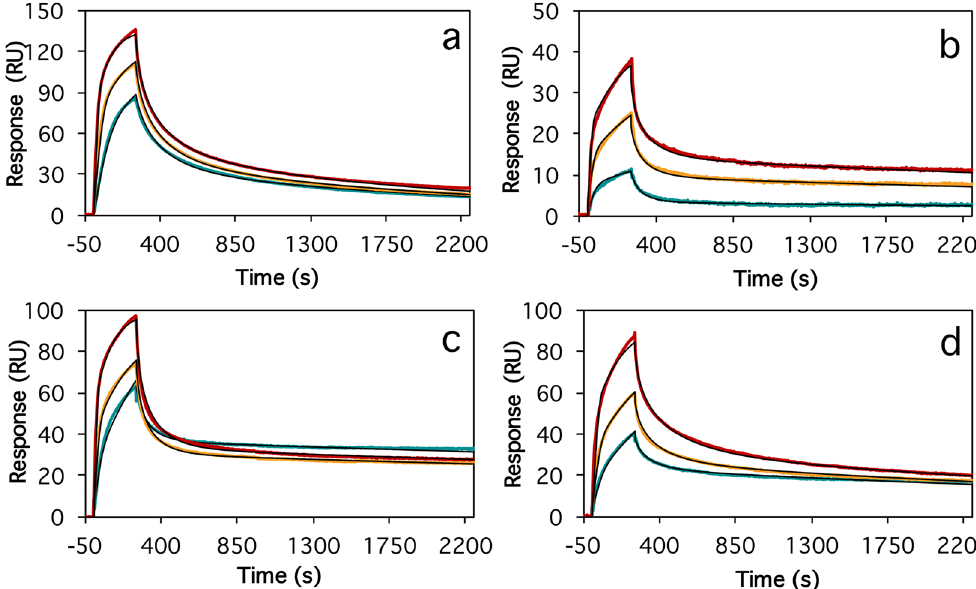
Figure 5. Association and dissociation kinetics for binding of some of the head-to-tail Affibody dimers to immobilized A β 42 cc protofibrils. Data were fit to a heterogeneous ligand binding model with local maximum response (R max ) values. ( a ) Z A β 42cc_1 -(GGGGS)- Z A β 42cc_1 -ABD with Affibody dimer concentrations of 10 (green), 20 (yellow) and 40 nM (red). The kinetics of the slow association and dissociation phases are k a = 3.1 ( ± 0.1) × 10 5 s − 1 M − 1 and k d = 5.2 ( ± 0.03) × 10 − 4 s − 1 corresponding to a dissociation constant for the stronger binding site of K D = 1.7 ( ± 0.1) nM. ( b ) Z A β 42cc_1 -(GGGGS) 4 - Z A β 42cc_1 -ABD; 10, 20 and 40 nM; k a = 1.4 ( ± 0.1) × 10 5 s − 1 M − 1 , k d = 1.6 ( ± 0.01) × 10 − 4 s − 1 , K D = 1.1 ( ± 0.1) nM. ( c ) Z A β 42cc_4 - Z A β 42cc_4 (no linker); 7.8, 15.5 and 31.2 nM; k a = 3.4 ( ± 0.1) × 10 5 s − 1 M − 1 , k d = 9.1 ( ± 0.01) × 10 − 5 s − 1 , K D = 0.27 ( ± 0.01) nM. ( d ) Z A β 42cc_4 - (GGGS) 4 - Z A β 42cc_4 ; 7.8, 15.5 and 31.2 nM; k a = 2.2 ( ± 0.3) × 10 5 s − 1 M − 1 , k d = 2.5 ( ± 0.01) × 10 − 4 s − 1 , K D = 1.1 ( ± 0.05)